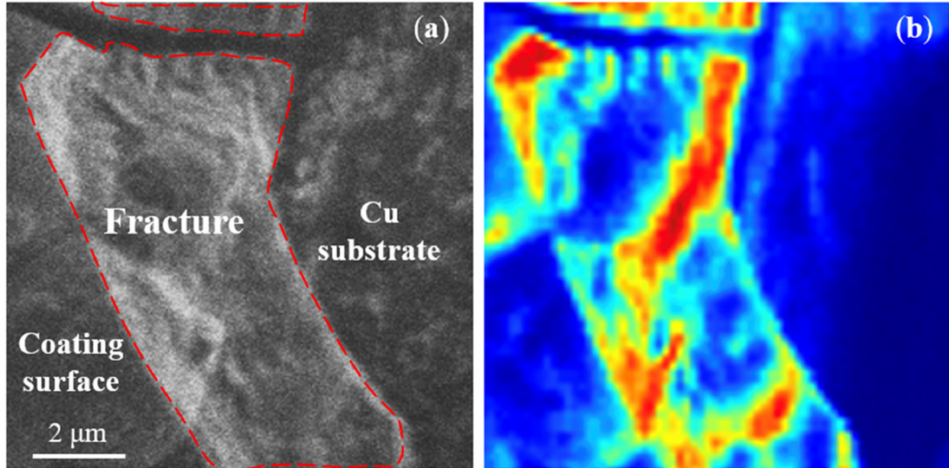
Figure 11. A fracture surface of coating A ( − 2.5 V vs. SSE; 0.6 ks) ( a ) and its lithium mapping by TOF-SIMS ( b ). Lithium was detected from the red and the light zones in ( b